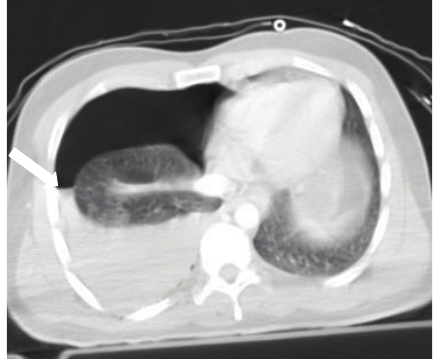
Figure 8: Pneumopericardium. A thin line of air is appreciated between the pericardium layers (arrow). Bilateral parenchymal contusions were also present.